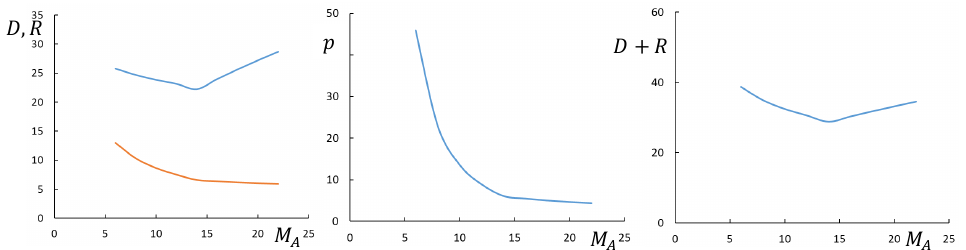
Figure 7. Aggregation number p , core radius, R (red), corona thickness, D (blue) and overall radius, R + D , of spherical micelles formed by block copolymers with N B = 200 as a function of M A at n A = 100. Other parameters are q A = 1, γ = 1, v = 1, φ B =